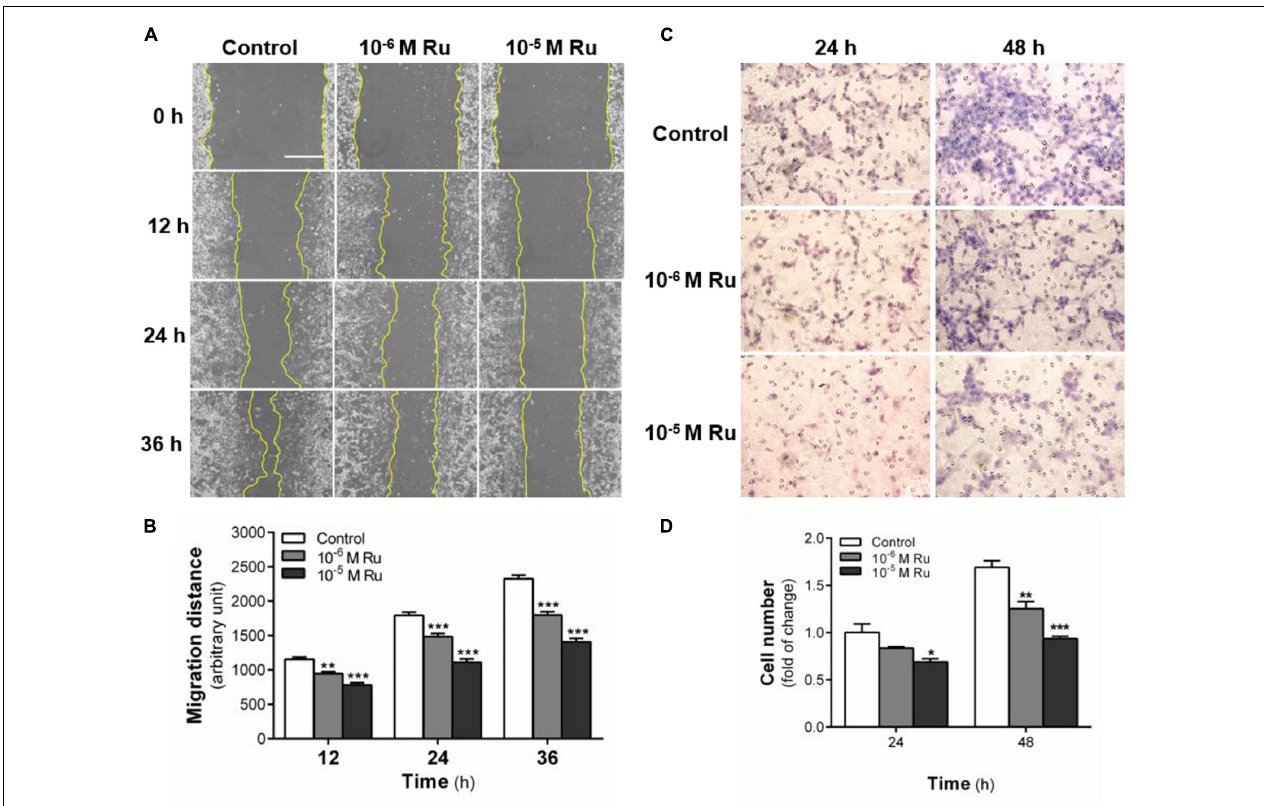
FIGURE 4 | Effect of rutaecarpine on the migration of U87 cells. Wound healing assay and transwell migration analysis were used to analyze U87 cells’ migration ability. (A) Typical images of wound healing assay were taken at 0, 12, 24, and 36 h about different treatment groups. Scale bar = 0.5 mm. (B) Quantitative data graph of wound healing assay. After 36 h treatment with 10 − 6 and 10 − 5 M rutaecarpine or 0.1% DMSO, the distance of migration was counted. (C) Typical images of transwell migration analysis were taken at 24 and 48 h about different treatment groups. Scale bar = 0.1 mm. (D) Quantitative data graph of transwell migration analysis after 24 h and 48 h treatment with 10 − 6 and 10 − 5 M rutaecarpine or 0.1% DMSO, the distance of migration was counted. * p < 0.05, ** p < 0.01, *** p < 0.001 compared with control group. All values are fold of control that was treated with the solvent and represent the mean ± SEM ( n = 3). SEM, standard error of the mean; Ru,